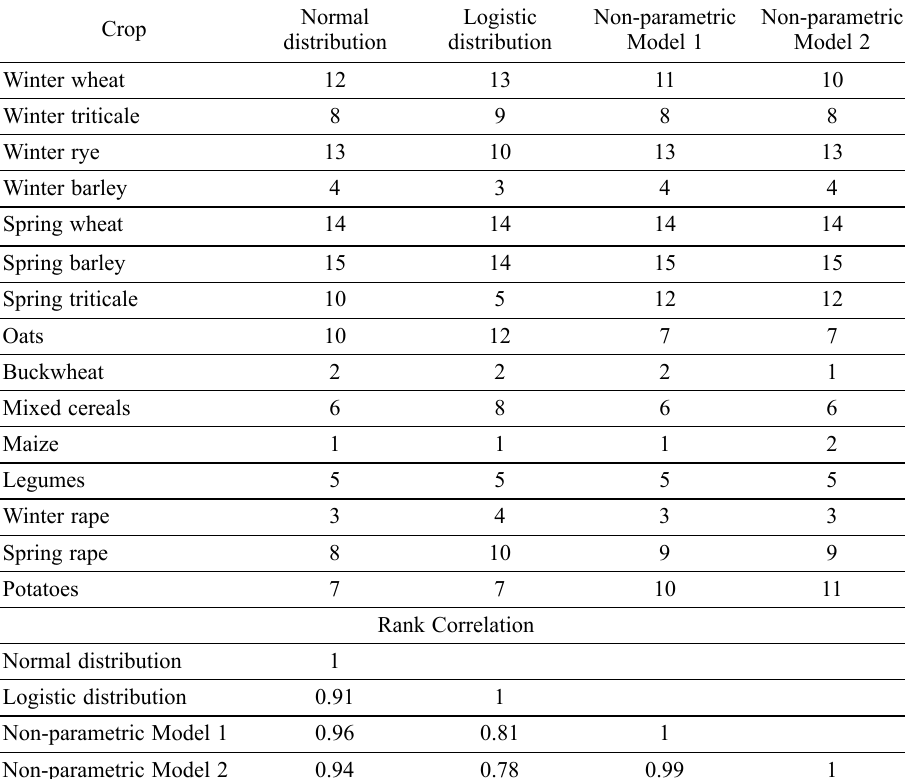
Table 4. Rankings of the crops based on the average measures of risk according to parametric and non-parametric approaches Crop